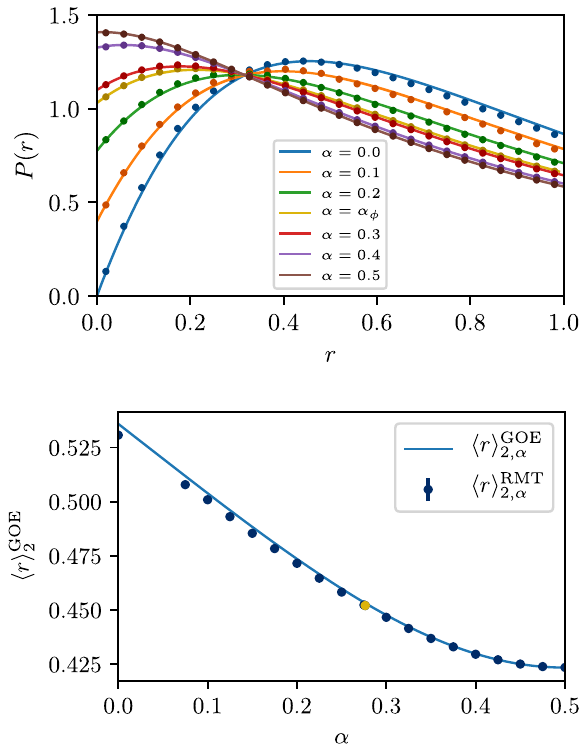
FIG. 3. Top panel: P GOE 2 ð r Þ , for various density ratios α (see text). Note that α ϕ ¼ 1 = ð 1 þ ϕ 2 Þ (in golden color in both plots) is the value that corresponds to the anyonic chain application discussed in Sec. IV D. Bottom panel: h r i GOE 2 as a function of α . In both plots, solid lines are predictions from the surmises of Sec. III, and points are numerical results obtained on random 2000 , averaged over 3 . 6 × 10 5 matrices of size at least N tot ¼